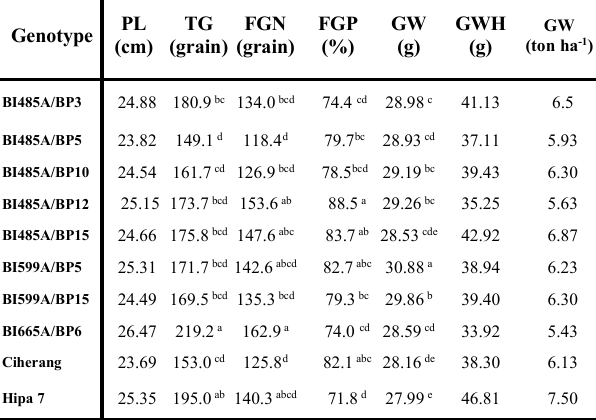
Table 4: Yield and yield components including panicle length (PL), total grain number (TGN), filled grain number (FGN), filled grain percentage (FGP), 1000 grain weight (GW), grain weight per hill (GWH), and grain yield (GY) of hybrid rice genotypes and check varieties in irrigated